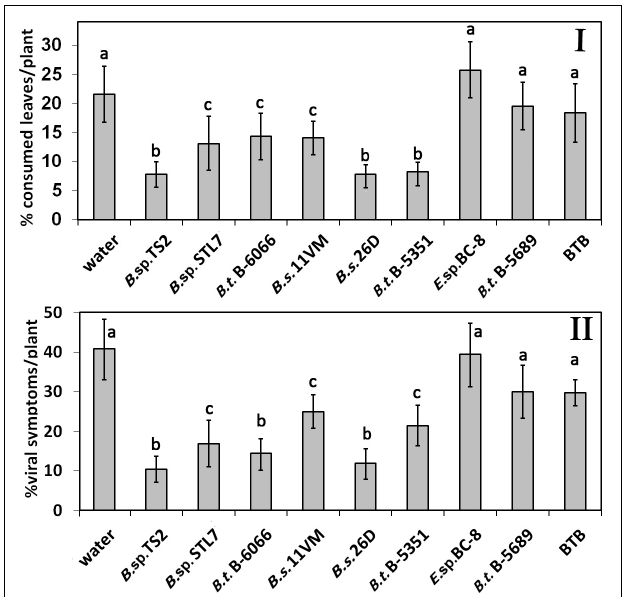
FIGURE 5 | Defoliation of potato plants caused by Leptinotarsa decemlineata (I) and percentage of viral diseases damaged leaves (II) of potato plants treated with bacterial agents and Bitoksibacilline (BTB). Data represented as mean values ± standard error; values followed by the same alphabet within a column are not significantly different from each other according to Tukey’s honestly significant difference (HSD) multiple-range test at P < 0.05.